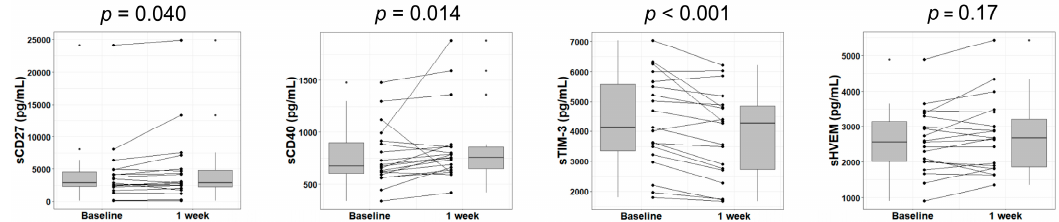
Figure 1. Changes in soluble immune checkpoint protein levels in plasma after 1 week of lenvatinib treatment. Box plots show the sCD27, sCD40, sTIM-3, and sHVEM levels in HCC patients at baseline and Week 1 of treatment. The vertical lengths of the boxes indicate the interquartile ranges and the lines in the boxes suggest the median values, while the error bars show the minimum and maximum values (in a range). The Wilcoxon signed-rank test was used. HCC, hepatocellular carcinoma; sTIM-3, soluble T-cell immunoglobulin and mucin domain–3; sHVEM, soluble herpesvirus entry mediator; sCD, soluble cluster of di ff erentiation.